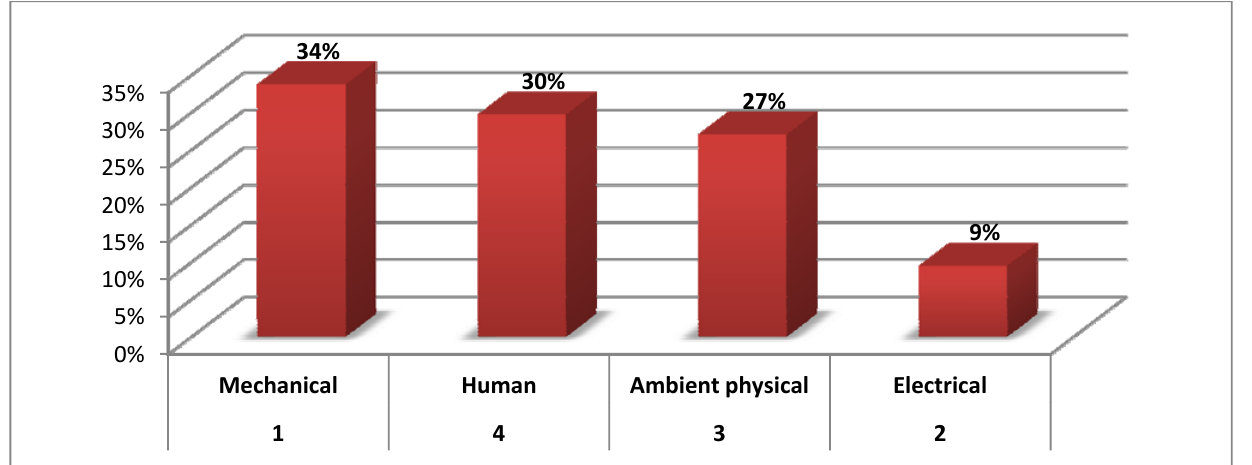
Figure 8. Criticality of different sources of hazards as perceived by consulted